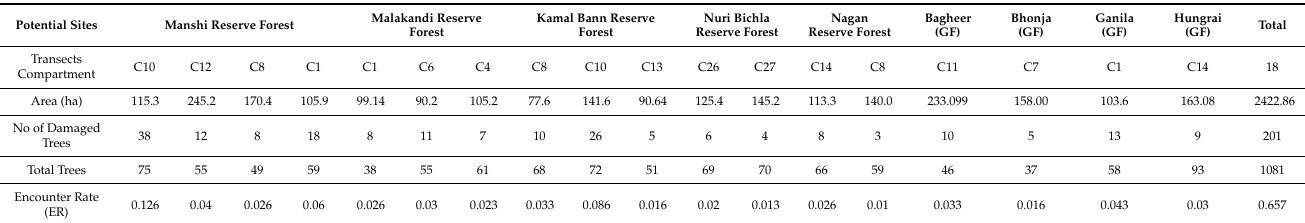
Table 1. Detail of the transects in Kaghan Valley,